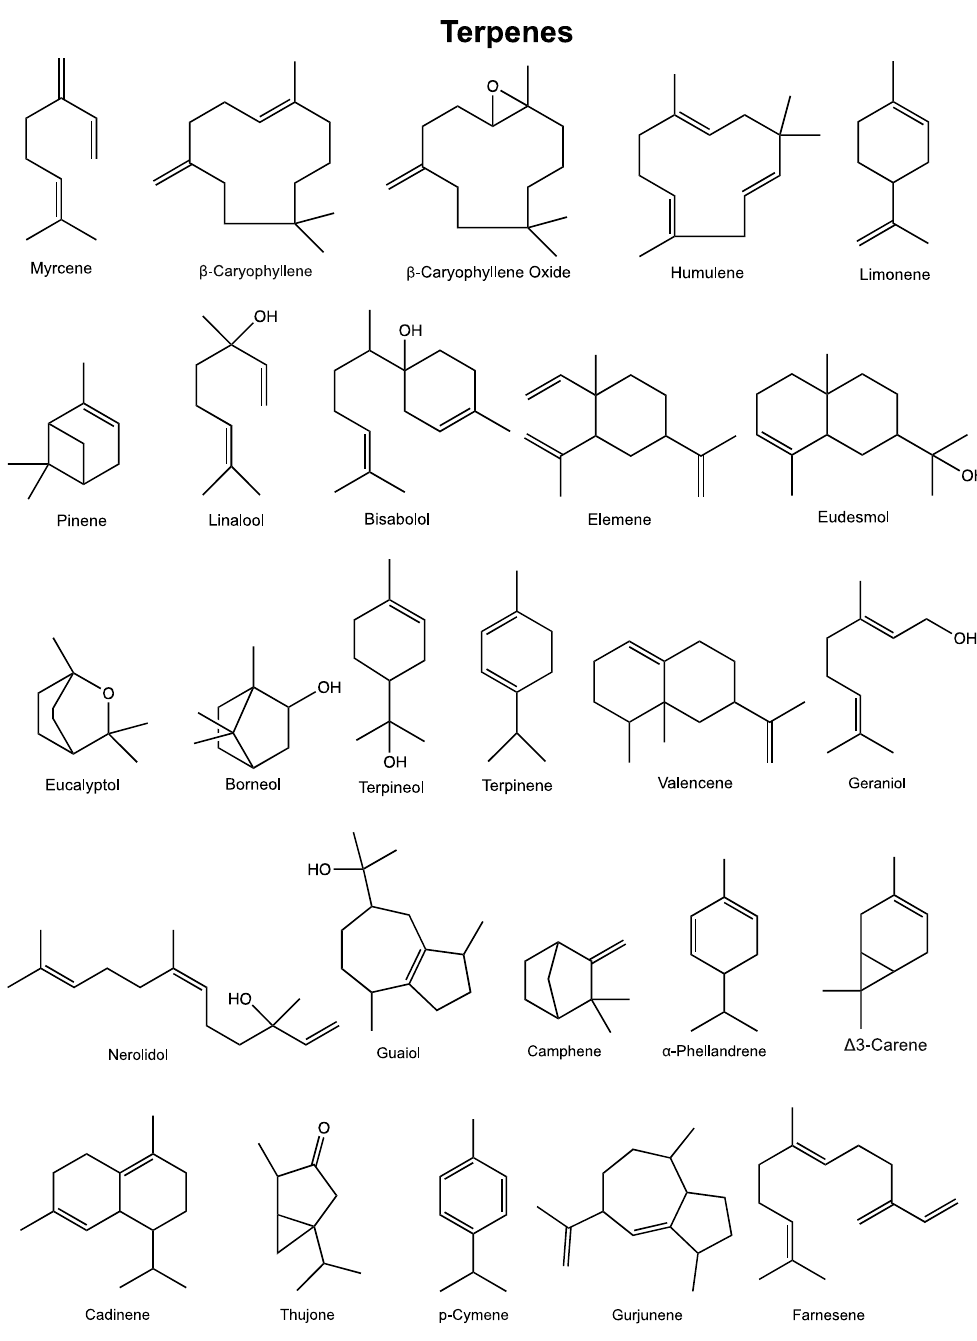
Figure 2. Structure of various terpenes found in the Cannabis